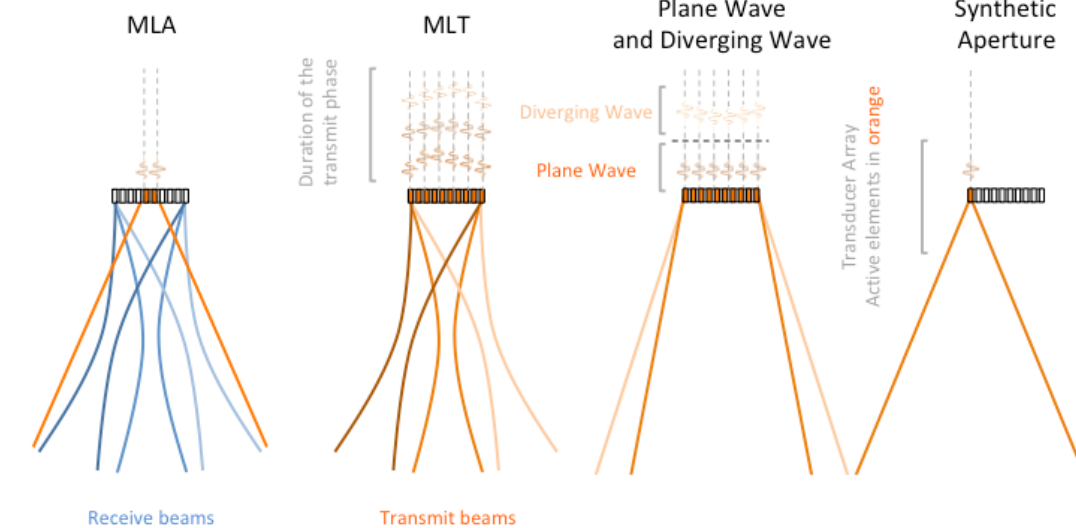
Figure 4. This figure illustrates the different driving schemes for MLA, multi-line transmission (MLT), plane wave, diverging wave, and synthetic aperture beam forming. The transmit beams are represented in orange, and different shades of orange are used to highlight multiple beams for MLT, and separate the beam profiles for plane and diverging wave, respectively. For MLA, the receive beams are also shown in shades of blue. The duration of the transmit phase is also emphasized for MLT.